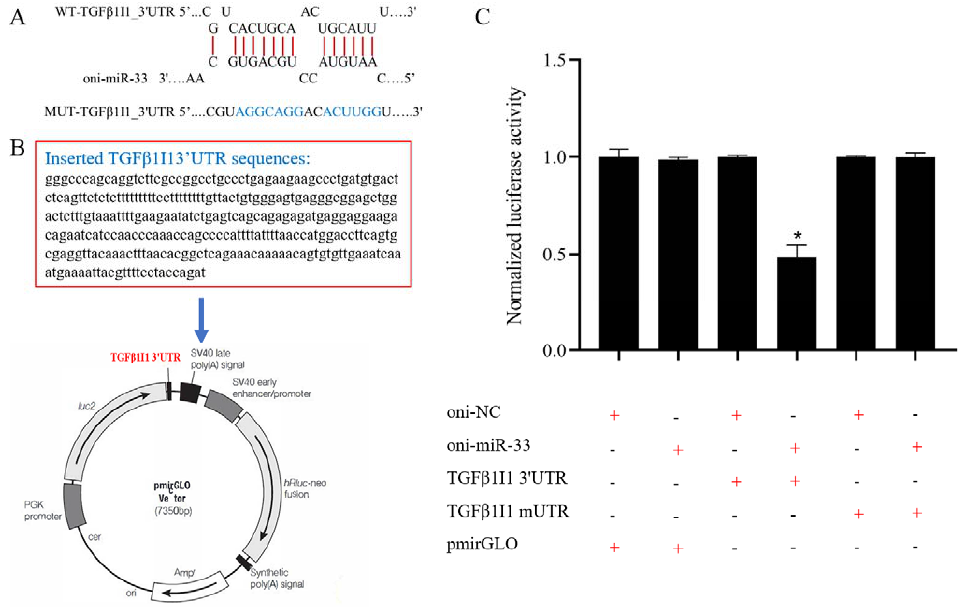
Figure 6. Identification of oni-miR-33 target gene TGF β 1I1. Note: ( A ) Schematic diagram of miR-33 binding to 3 ′ -untranslated region (UTR) of TGF β 1I1 , and wild or mutated UTR (mUTR) of tilapia TGF β 1I1. ( B ) Plasmid containing 3 ′ -UTR of TGF β 1I1 used for luciferase reporter analysis; ( C ) Luciferase activity in cells co-transfected with the TGF β 1I1 3 ′ -UTR luciferase reporter plasmid and oni-miR-33 and pmirGLO, the pmirGLO- TGF β 1I1 3 ′ -UTR, or pmirGLO- TGF β 1I1 mUTR. * indicates statistical significance among different treatment groups ( p < 0.05).